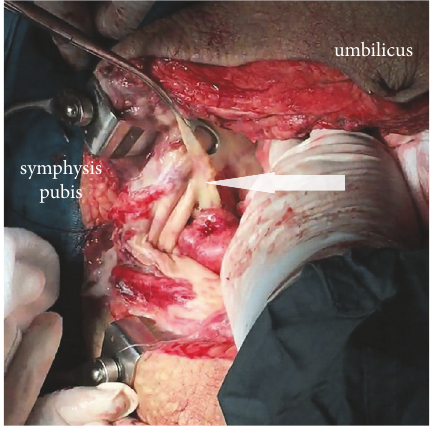
Figure 4: Extensive necrosis of perivesical fat (arrow) and presence of pus in the retropubic